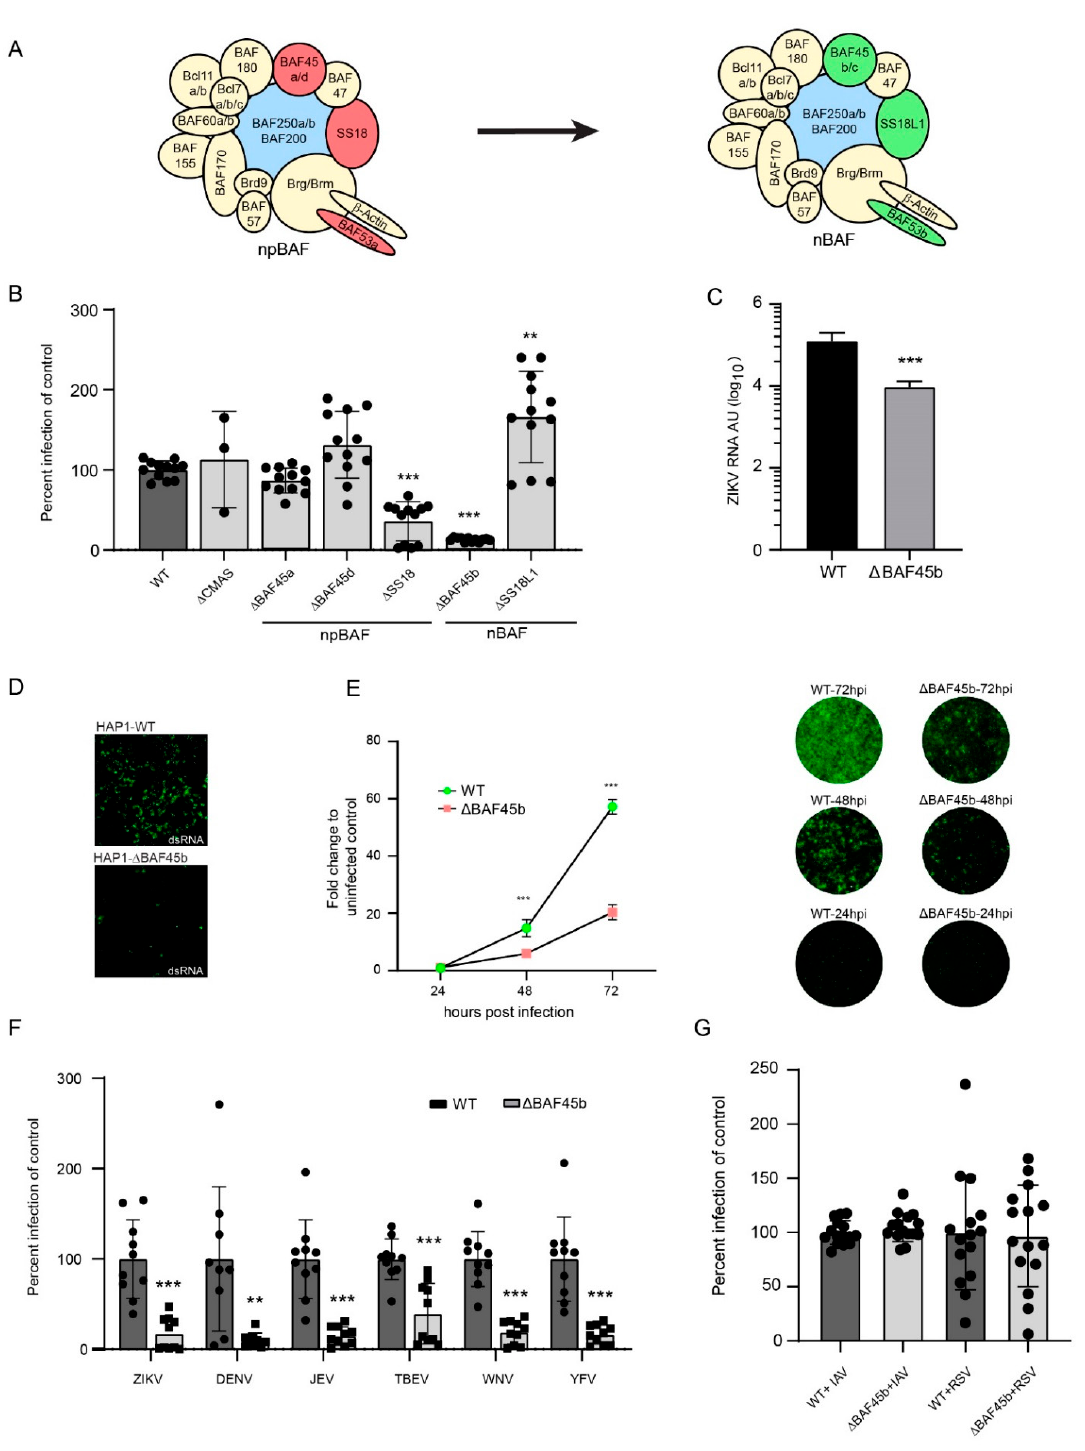
Figure 2. BAF45b and other members of the BAF complexes are required for efficient infection with ZIKV and other flaviviruses. ( A ) An illustration of the BAF complex and how selected subunits are exchanged during transition from neural progenitor BAF to neuronal (postmitotic) BAF. ( B ) Quantification of ZIKV Env protein in WT and HAP1 cells deleted in genes encoding CMAS (control) and members of the BAF complex using pan-flavivirus anti-Env-binding 4G2 antibody 48 h post infec- tion. ( C ) Quantification of ZIKV E RNA in WT and Δ BAF45b HAP1 cells by qRT-PCR 48 h post